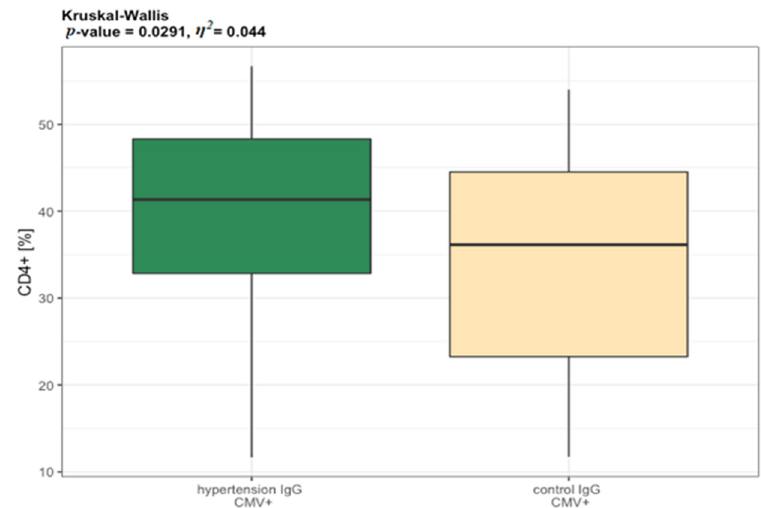
Figure 6. Distribution of T lymphocytes phenotypes in relation to CMV serostatus. Differences between hypertension ( n = 44) vs. controls ( n = 43). Abbreviations: CMV+ cytomegalovirus positive. The measurements in groups were compared by the one-way ANOVA or the Kruskal-Wallis non- parametric test (if the normality assumption is violated). η 2 is a measure of effect size.